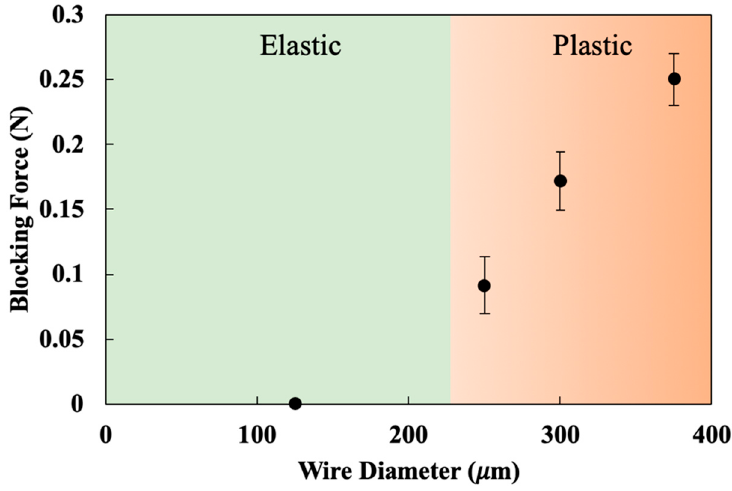
Figure 9. Blocking force test results with regions where wires are predicted to undergo pure elastic or elasto–plastic